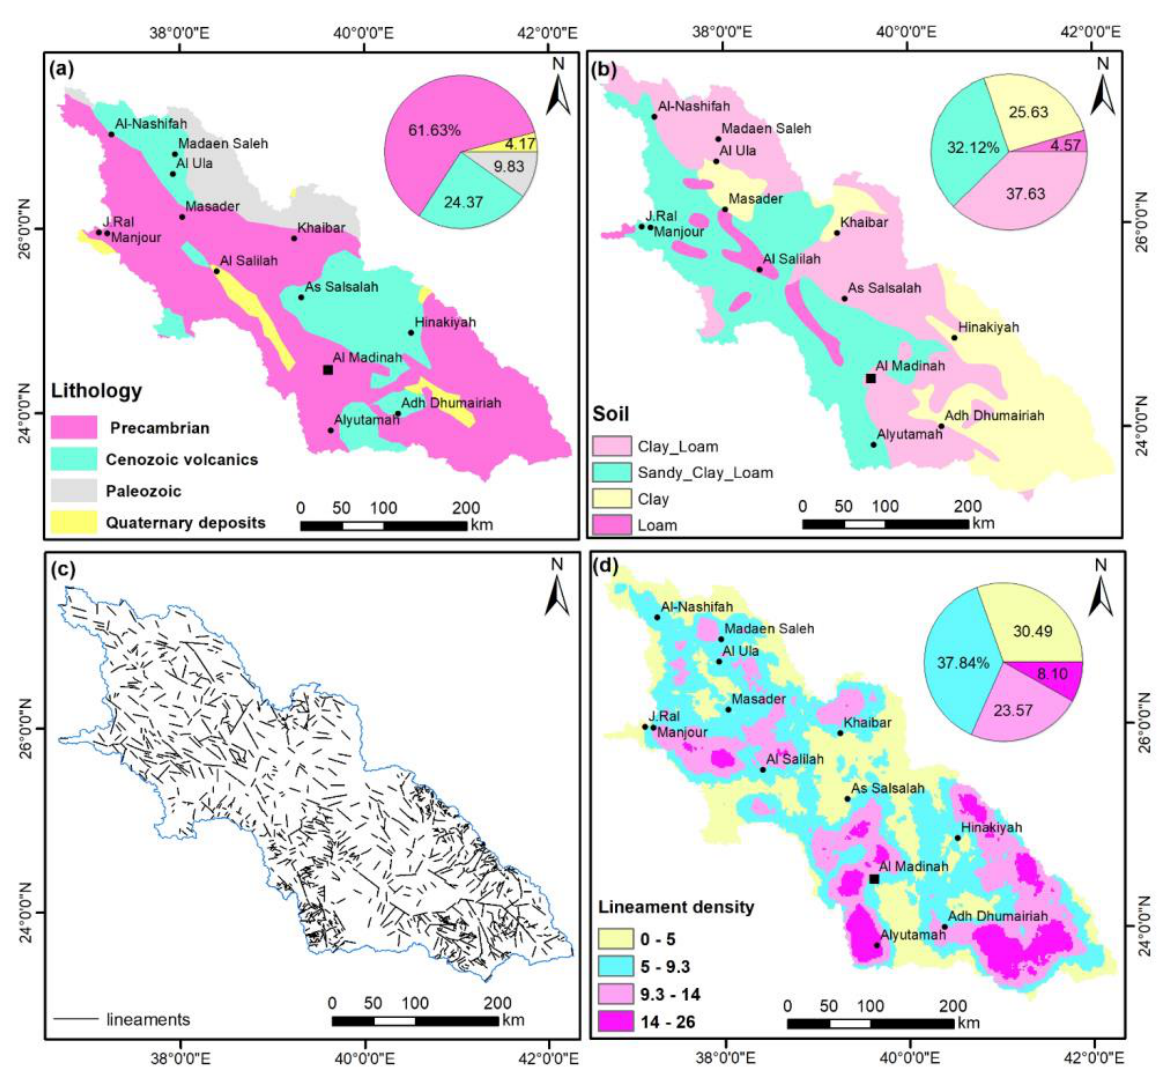
Figure 5. Geologic factors; ( a ) lithology; ( b ) soil; ( c ) lineaments; ( d ) lineament density map.